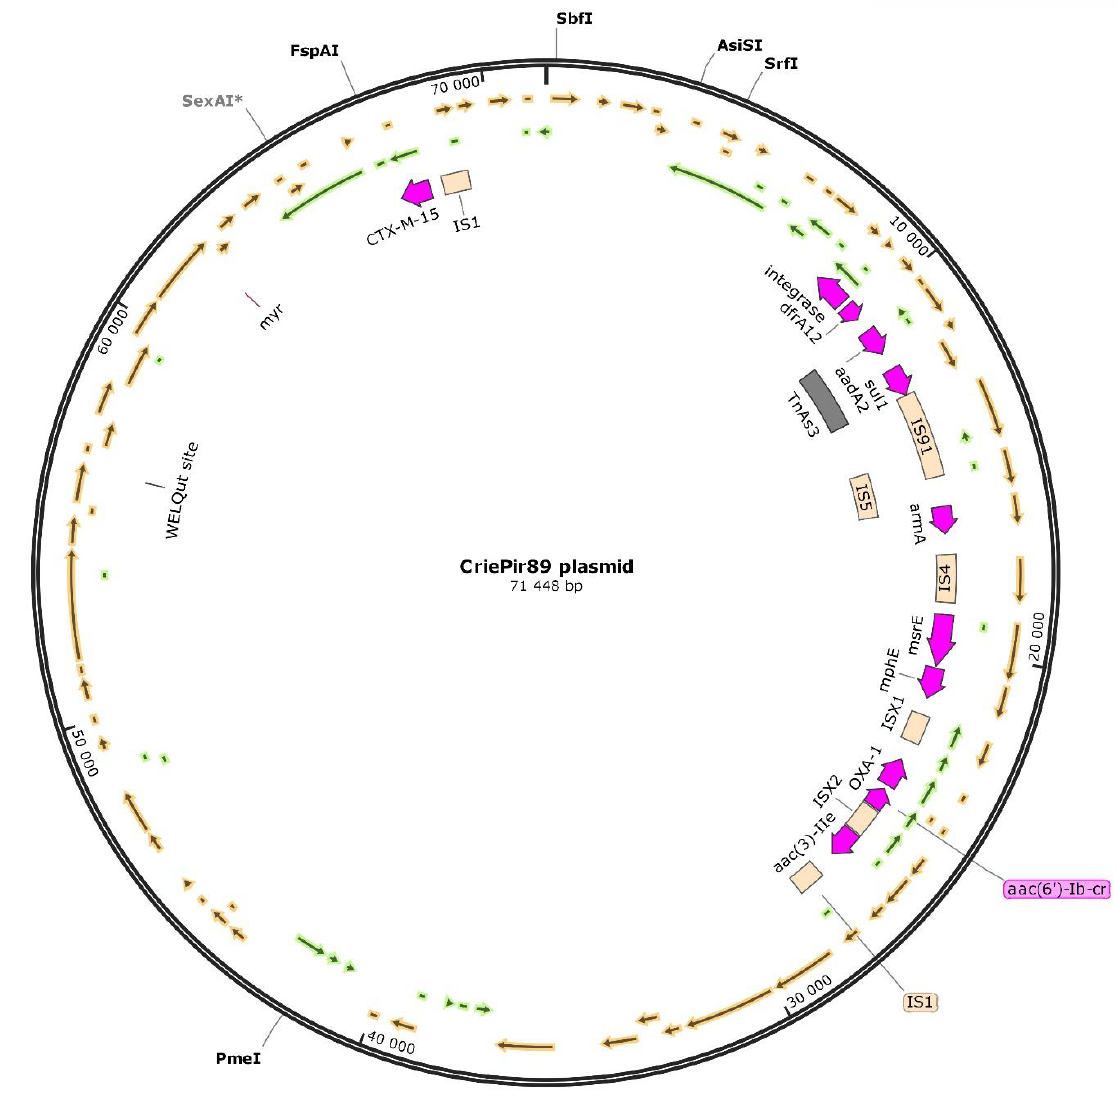
Figure 1. Plasmid structure for CriePir89 isolate.